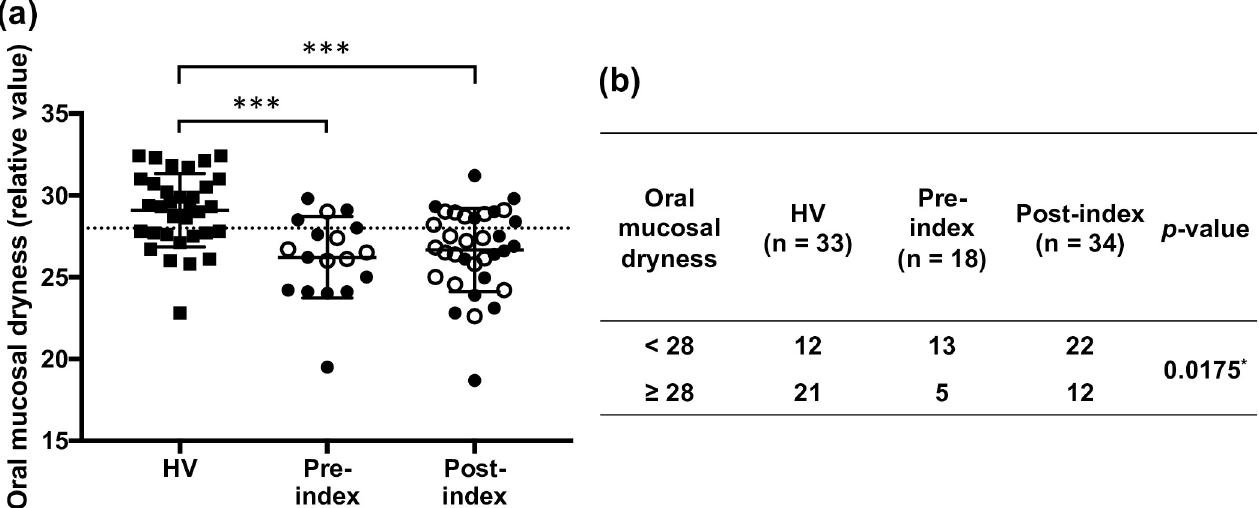
Fig 2. Comparison of oral mucosal dryness between HV (n = 33) and pre- and post-index patients with cancer (n = 18 and n = 34, respectively). All data for the post-index group are obtained at sampling points 2 within 3 days of an OM event, 3 if and when the OM event improved or worsened, and 4 within 7 days after treatment completion. (a) Data are shown as means ± standard deviations. The closed circles for the index groups represent patients with leukemia, while the open circles represent patients with head and neck carcinoma. Oral mucosal dryness has no unit. The dotted line shows the cut-off value for dryness (y = 28). Statistical differences between the HV and each index group are analyzed using Dunn’s multiple comparisons test ( ��� p < 0.001). (b) Oral mucosal dryness is divided into two groups ( < 28 and � 28), and the frequency is analyzed using the Chi-square test ( � p < 0.05). HV, healthy volunteers; OM, oral